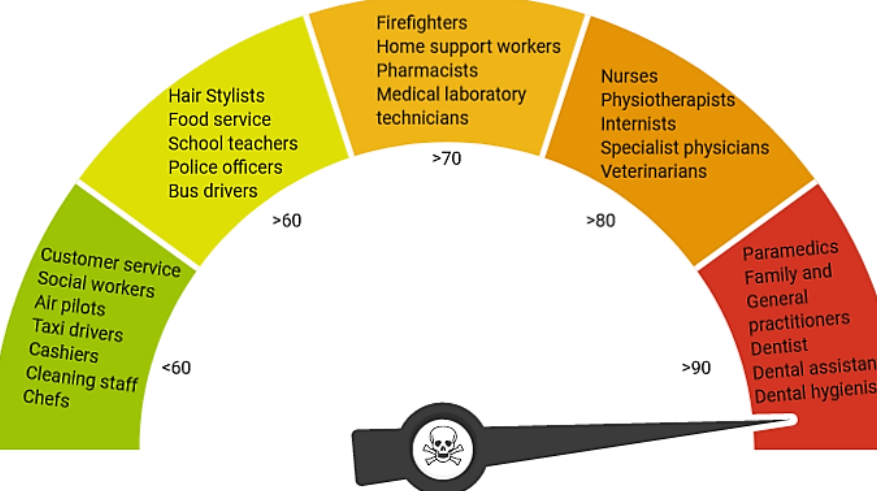
Figure 1. Risk of exposure to SARS-CoV-2 based on the Alberta Federation of Labour (created in BioRender.com).